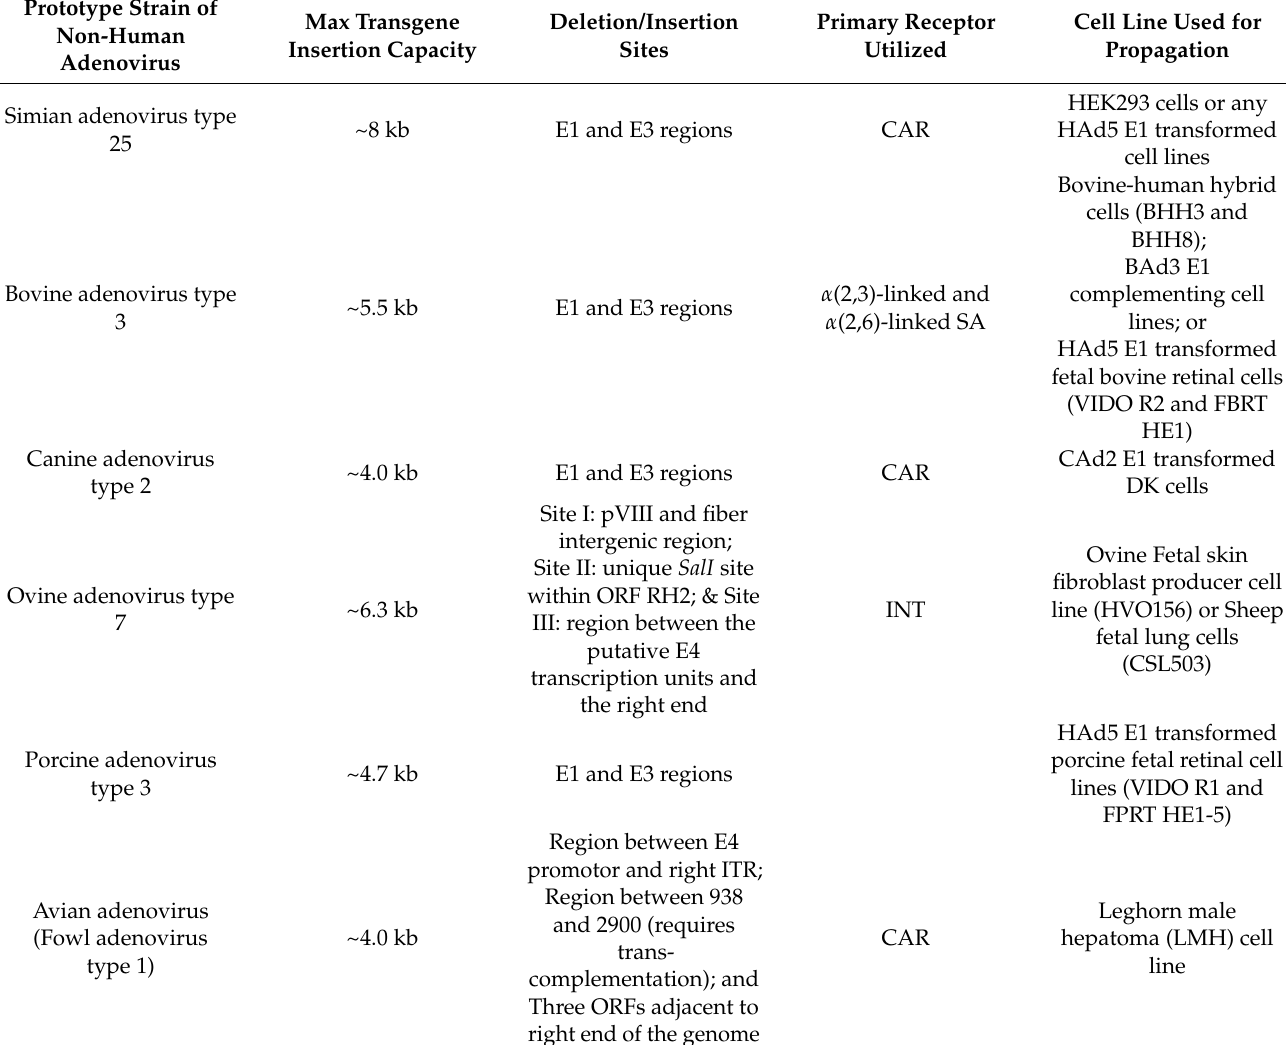
Table 1. Key properties of various nonhuman adenoviral vectors for vaccine